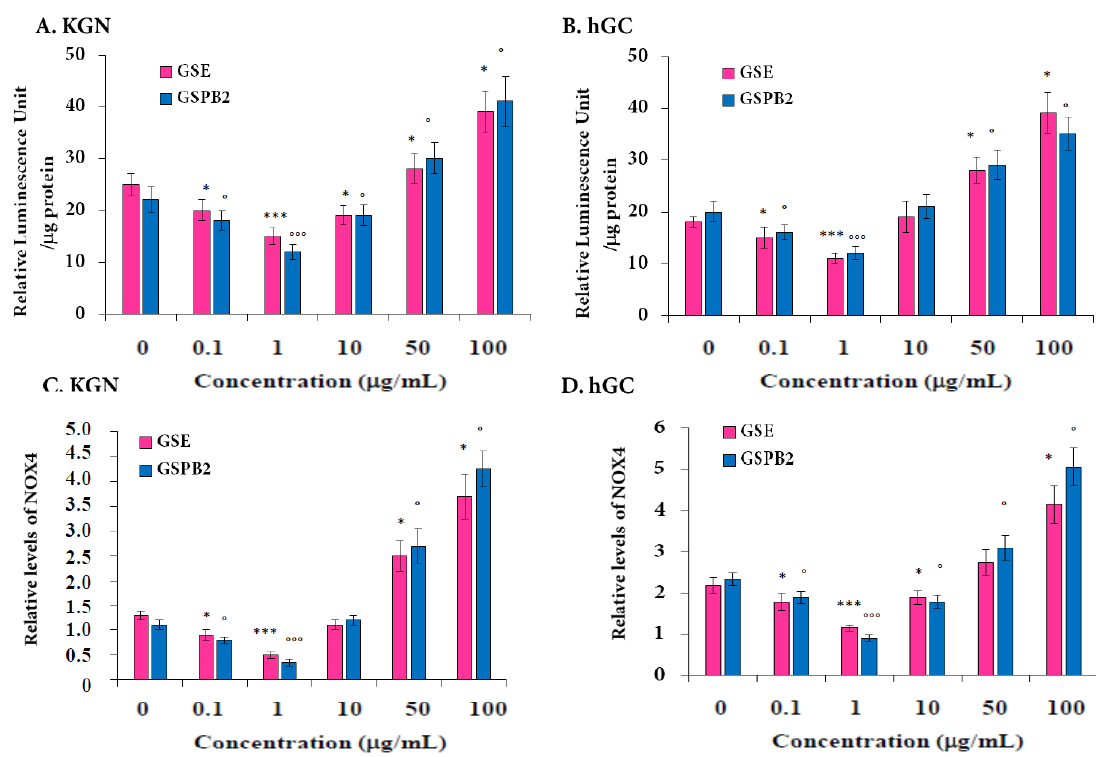
Figure 6. Determination of ROS content by using ROS-Glo assay ( A , B ) and mRNA expression of NOX4 ( C , D ) in response to GSE and GSPB2 treatments in human granulosa cells. KGN ( A , C ) and hGC ( B , D ) cells were plated 24 h before the experiment in 24-well plates. After that, cells were treated with di ff erent concentrations of GSE or GSPB2 (0, 1, 10, 50, and 100 µ g / mL) for 24 h in appropriate culture medium containing serum. Cellular oxidative stress was considered by measuring the ROS using ROS-Glo assay as described in Materials and Methods. ( C , D ) mRNA expression of NOX4 by RT-qPCR in KGN ( C ) and hGC ( D ) cells. The results are means ± SEM of four independent cultures with each condition in duplicate. For hGC cells, an independent culture was from a pool of cells collected from three patients. * and *** represent a significant e ff ect of GSE as compared to the control at p ≤ 0.05 and p ≤ 0.001, respectively. ◦ and ◦◦◦ represent a significant e ff ect of GSPB2 as compared to the control at p ≤ 0.05 and p ≤ 0.001,